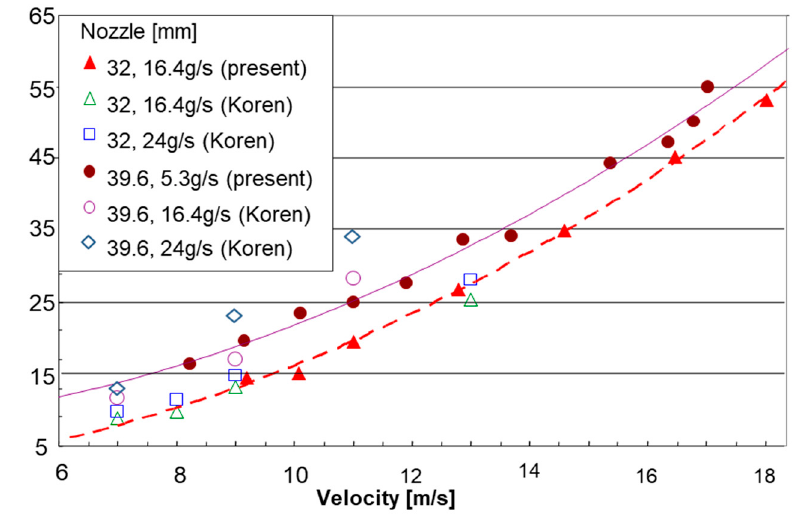
Figure 12. Test results of the thrust vs. propulsor velocity using air injection for 32 mm and 39.6 mm outlet nozzles.